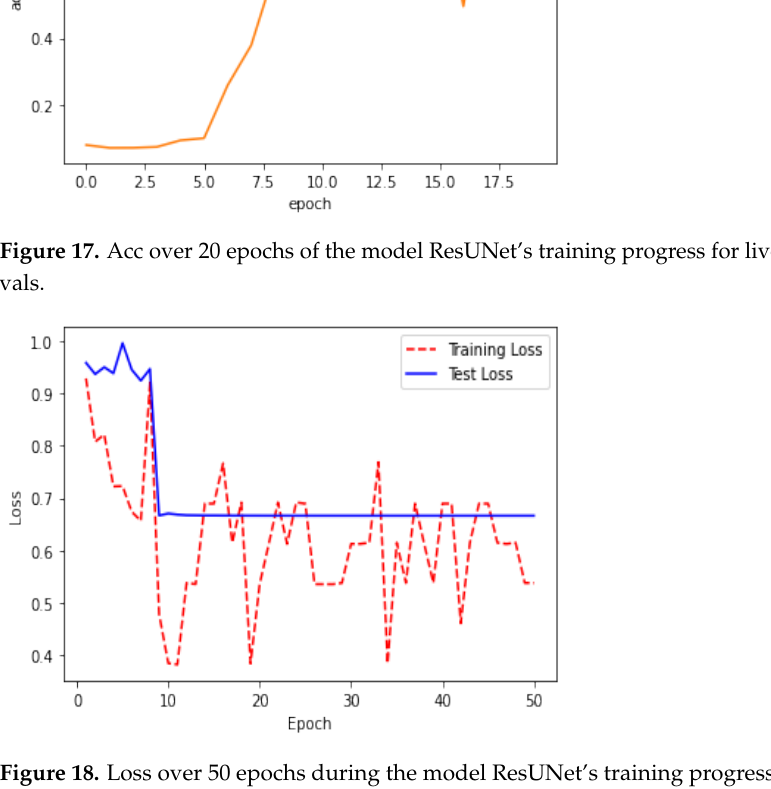
Figure 18. Loss over 50 epochs during the model ResUNet’s training progress for tumor segmenta- tion